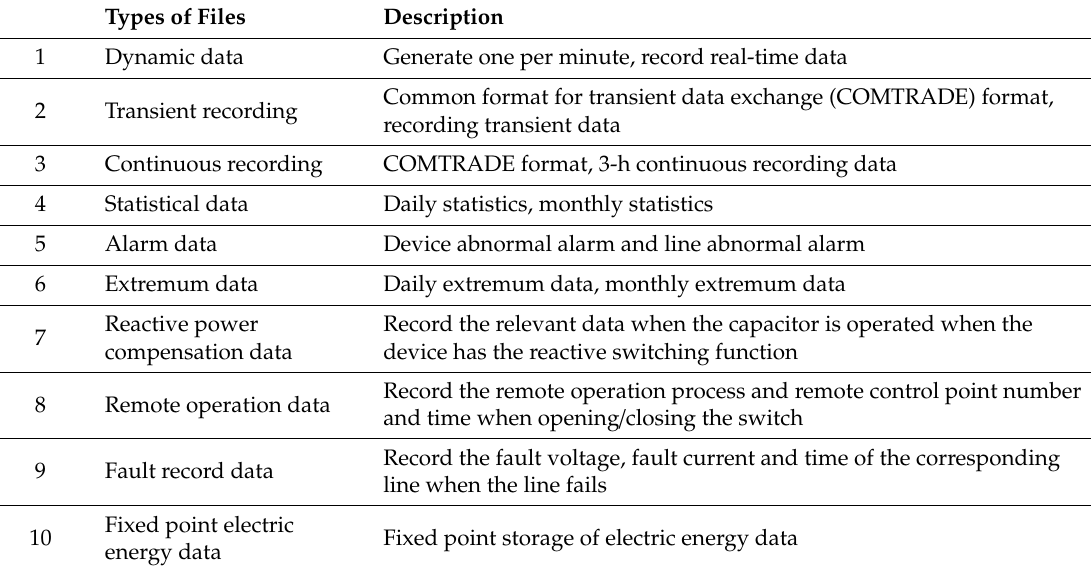
Table 4. Types of files.